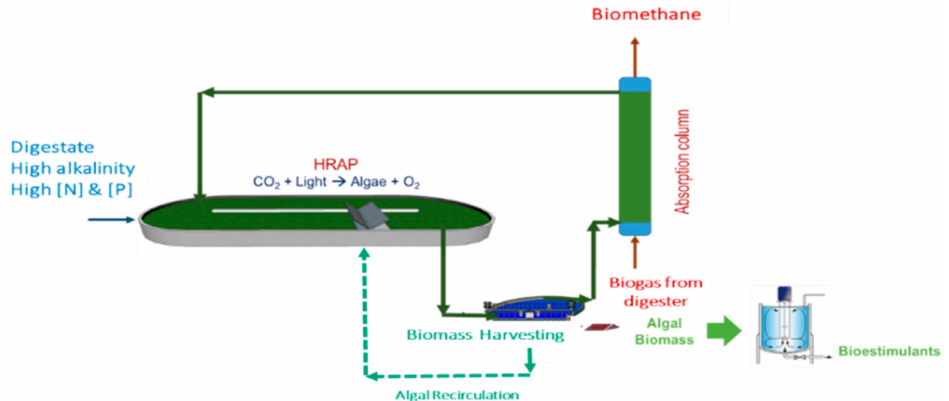
Figure 14. Process configuration of photosynthetic biogas upgrading using